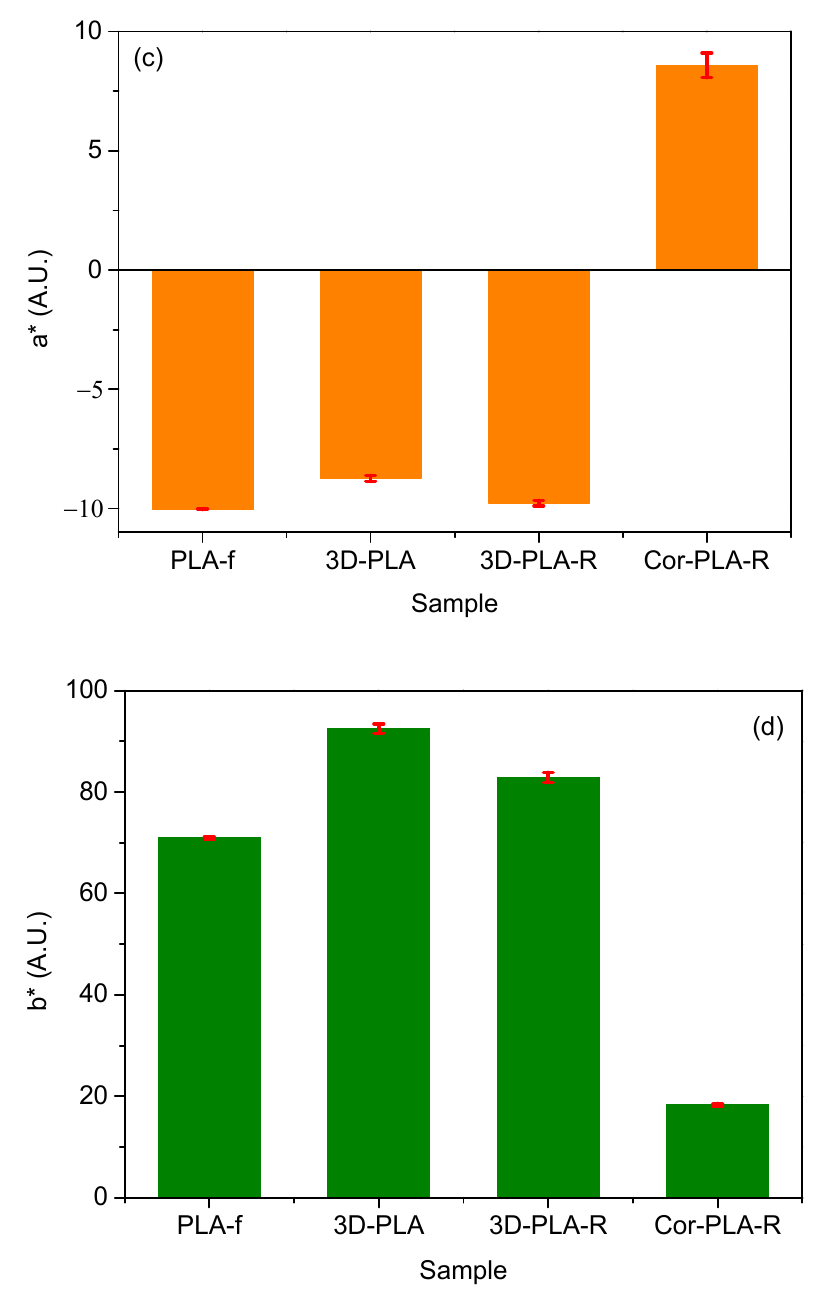
Figure 10. Visible spectra ( a ) and L * ( b ), a * ( c ), and b * ( d ) parameters of the different samples.